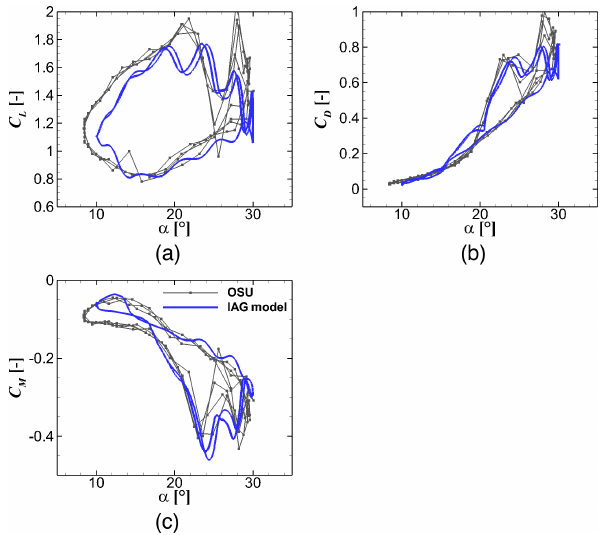
Figure 9. Dynamic force reconstruction using the IAG model in comparison with the measurement data (Ramsay et al., 1996) for (cid:49)t = T/ 1440. S801 airfoil, k = 0 . 073, α = 20 ◦ and (cid:49)α = 10 ◦ .